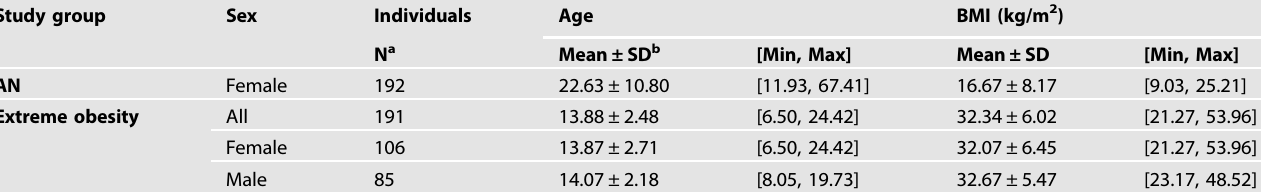
Table 1. Description of the study